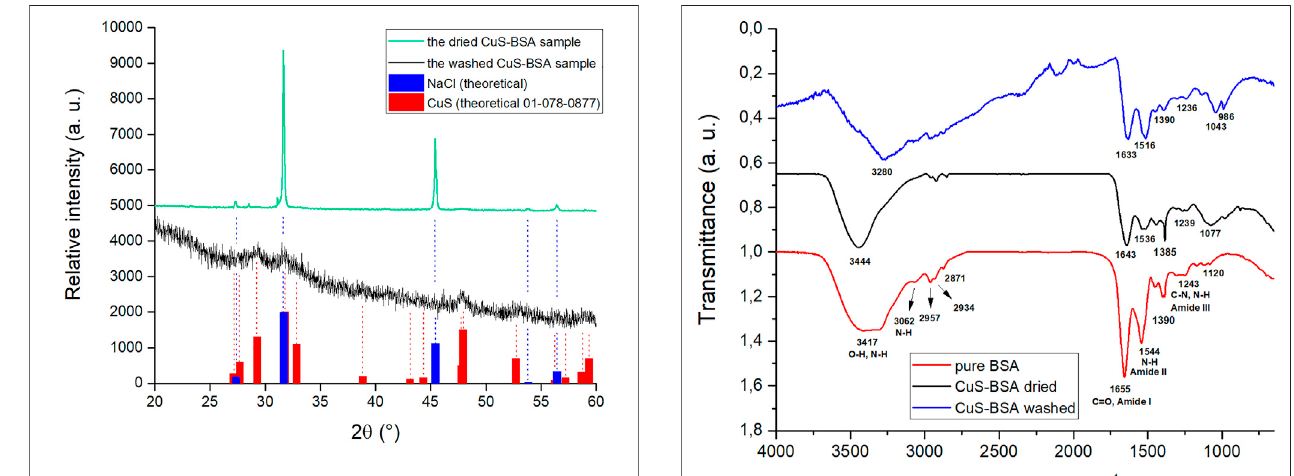
FIGURE 8 | The XRD patterns of the dried nanosuspension and the washed powder.